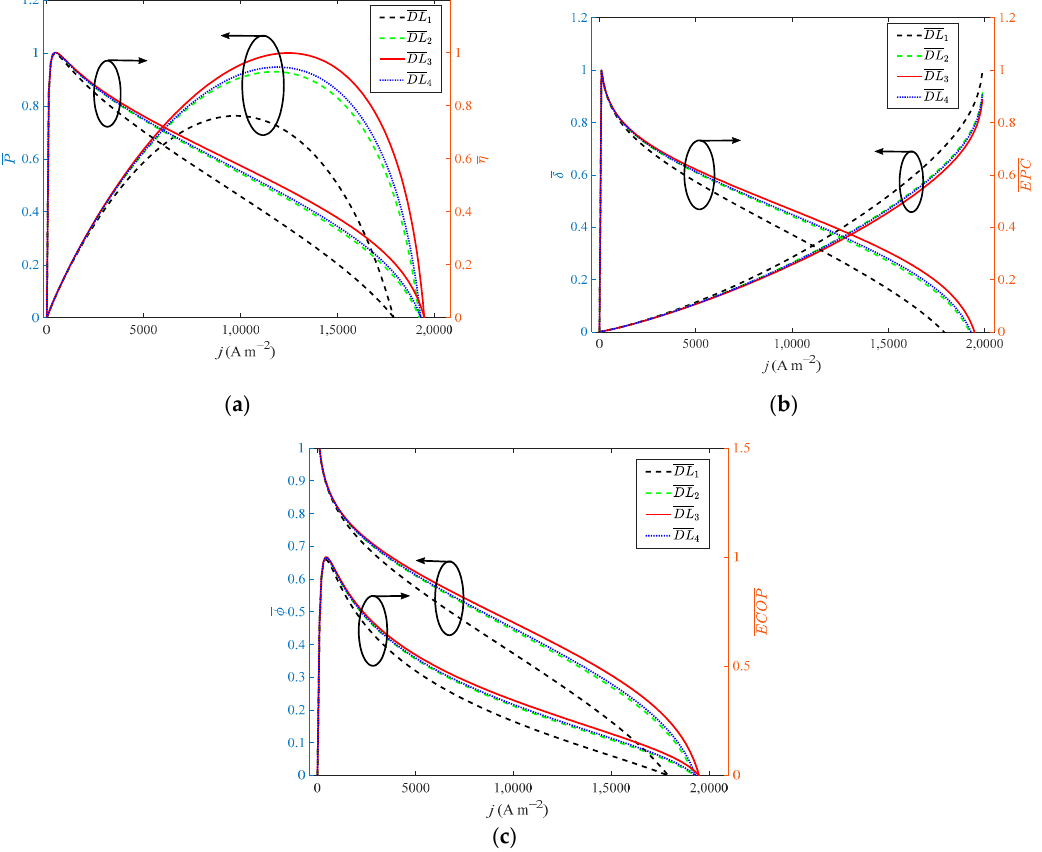
Figure 7. Different indexes vary with current density at different doping level: ( a ) P and η ; ( b ) δ and EPC ; ( c ) φ and ECOP .